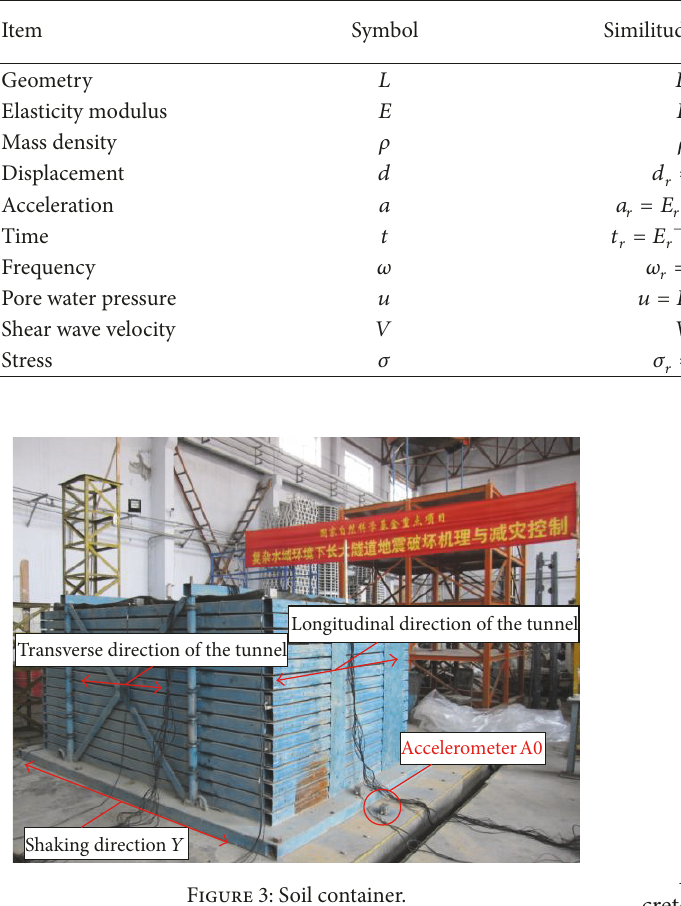
Figure 3: Soil container.